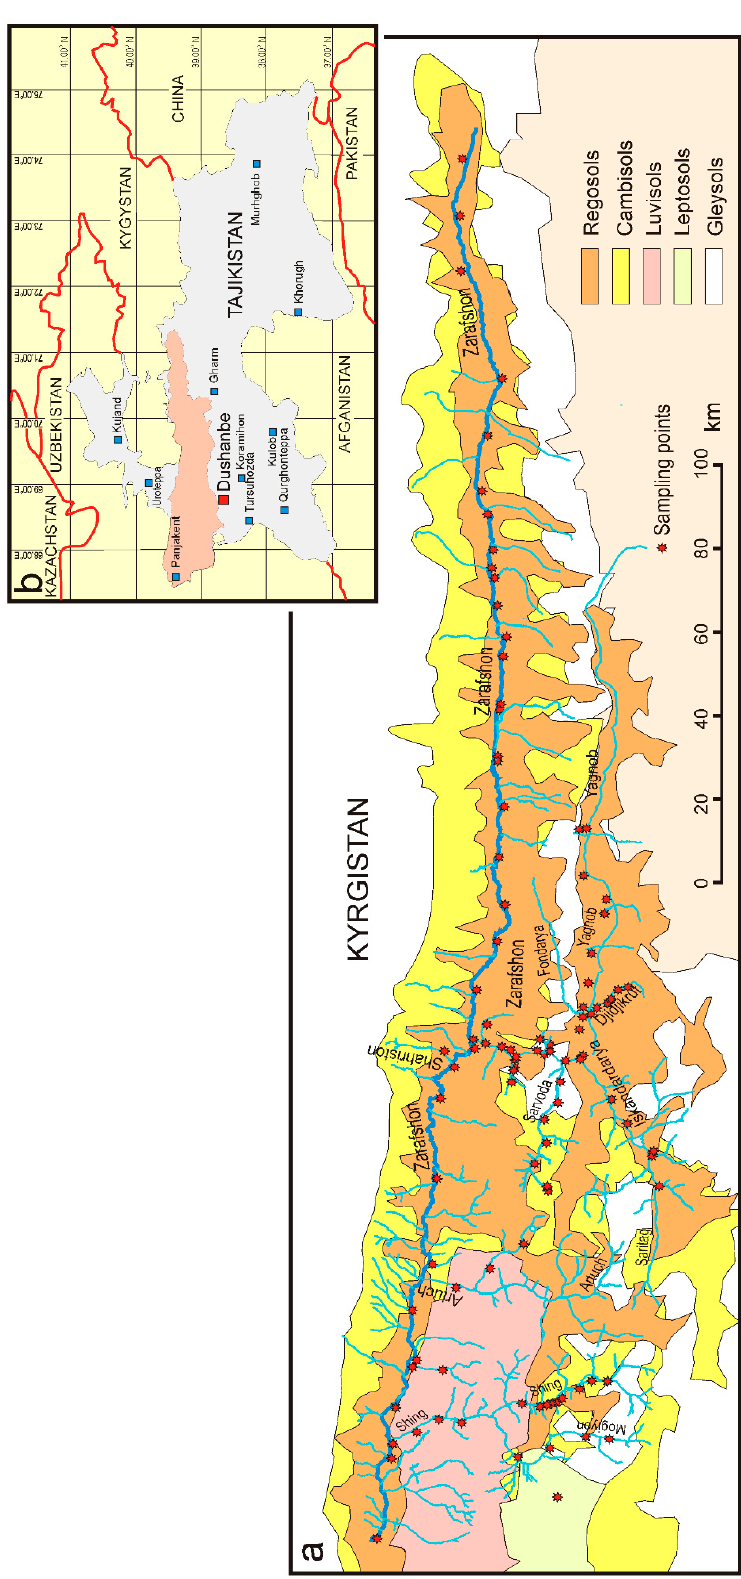
Figure 1. The map of Zarafshon Valley ( a ); showing its position within Tajikistan territory ( b ).